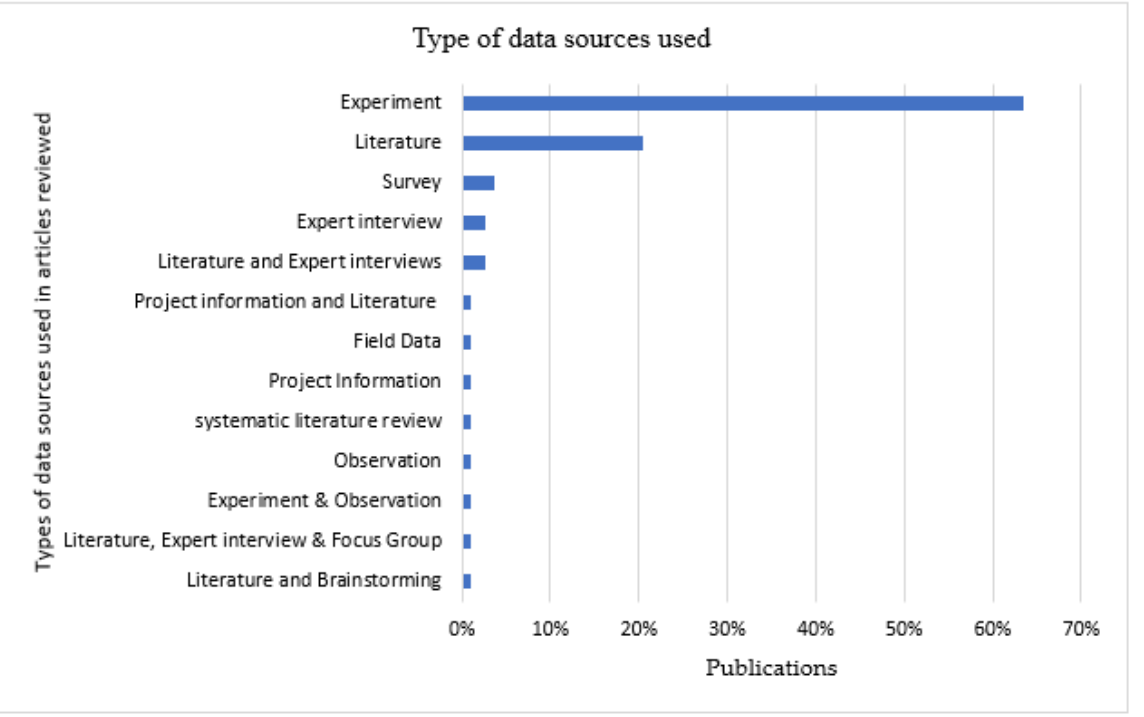
Figure 8. Data sources used in the construction robotics and human–robot teams literature.